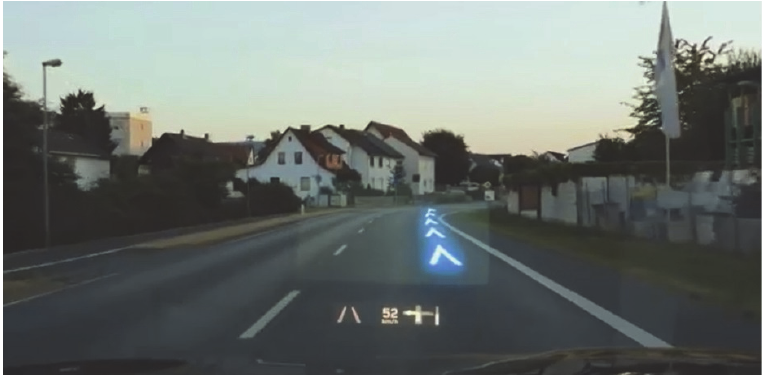
Fig. 3 Continental Augmented Reality Head-up Prototype: Augmented guidance and AR head-up display area (above) in combination with conventional head-up (below). In both cases the display area is visible as enlightened background in this image. Screenshot from (Continental/SAE 2018); 0:42 min. Image courtesy of Continental